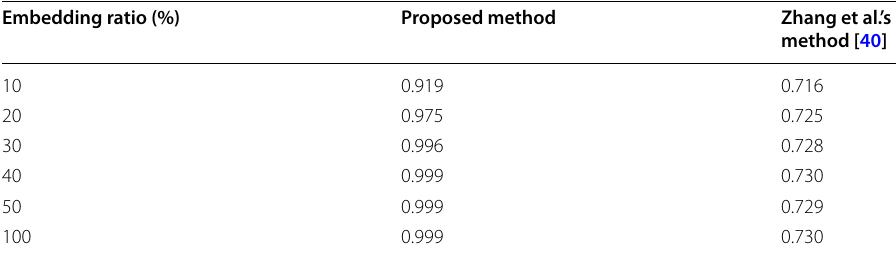
Table 9 Comparison of the accuracy for the UCID database images Embedding ratio (%)